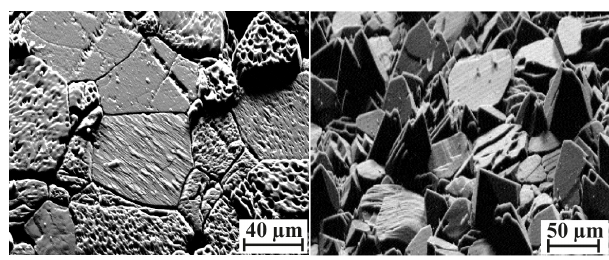
Figure 4. SEM images indicate differences in development of spe- cific crystallographic surfaces for samples annealed at 568 ◦ C and 260MPa for 47.7h (left) and at 441 ◦ C and 195MPa for 72h (right). The idiomorphic tips likely indicate the orientation of c axes.